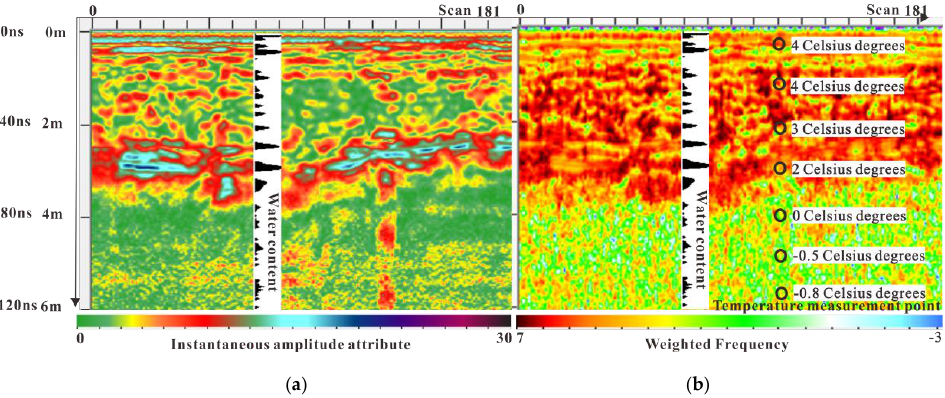
Figure 9. Correspondence diagram between electromagnetic wave attribute and measured data. ( a ) Absolute instantaneous amplitude attribute; ( b ) weighted average frequency attribute; water content is inserted in ( a ) and ( b ); black circle notes temperature in ( b ). The dielectric constant of the medium is 11.